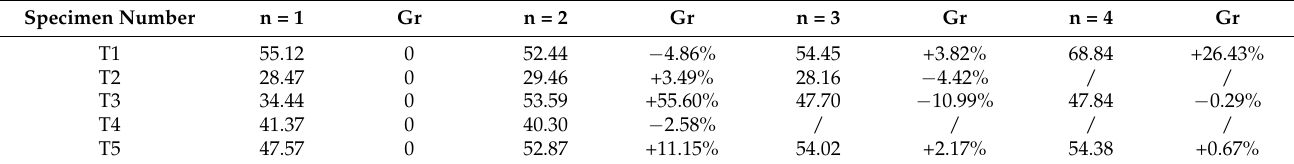
Figure 5. Visual CCD image of buckling lining.